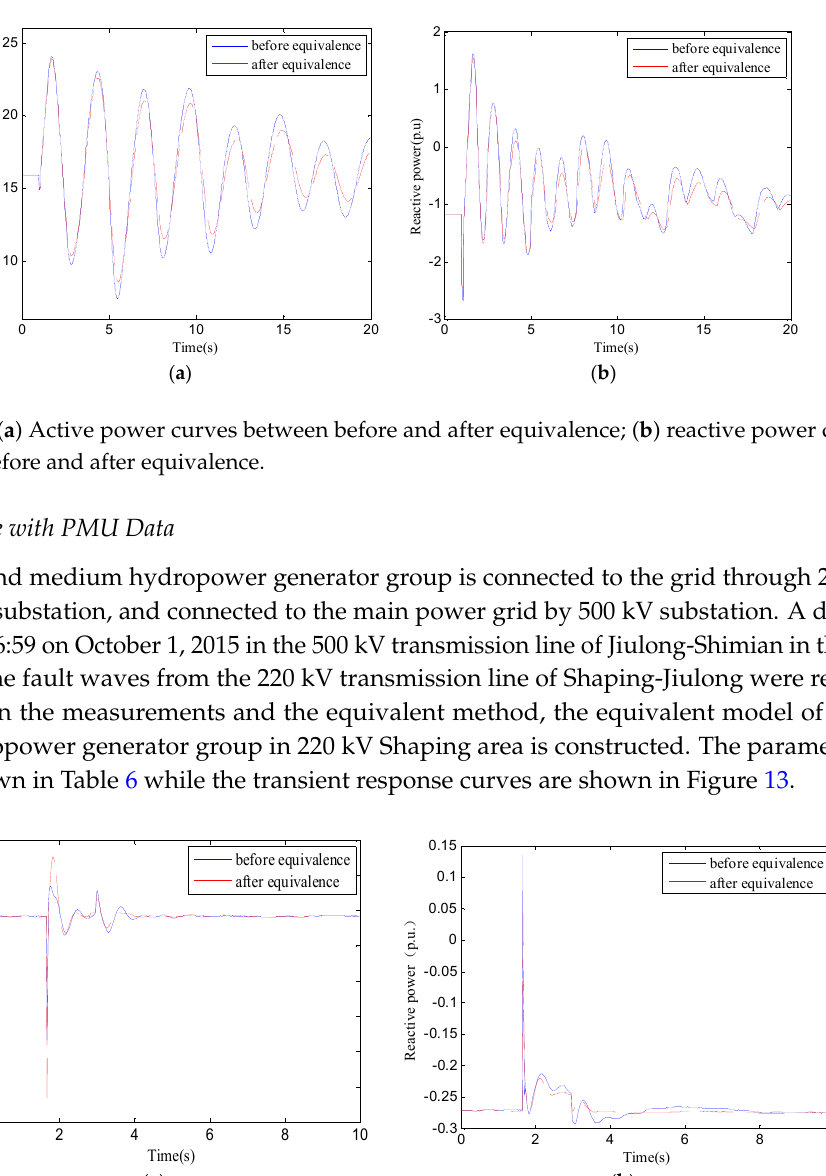
between before and after equivalence.